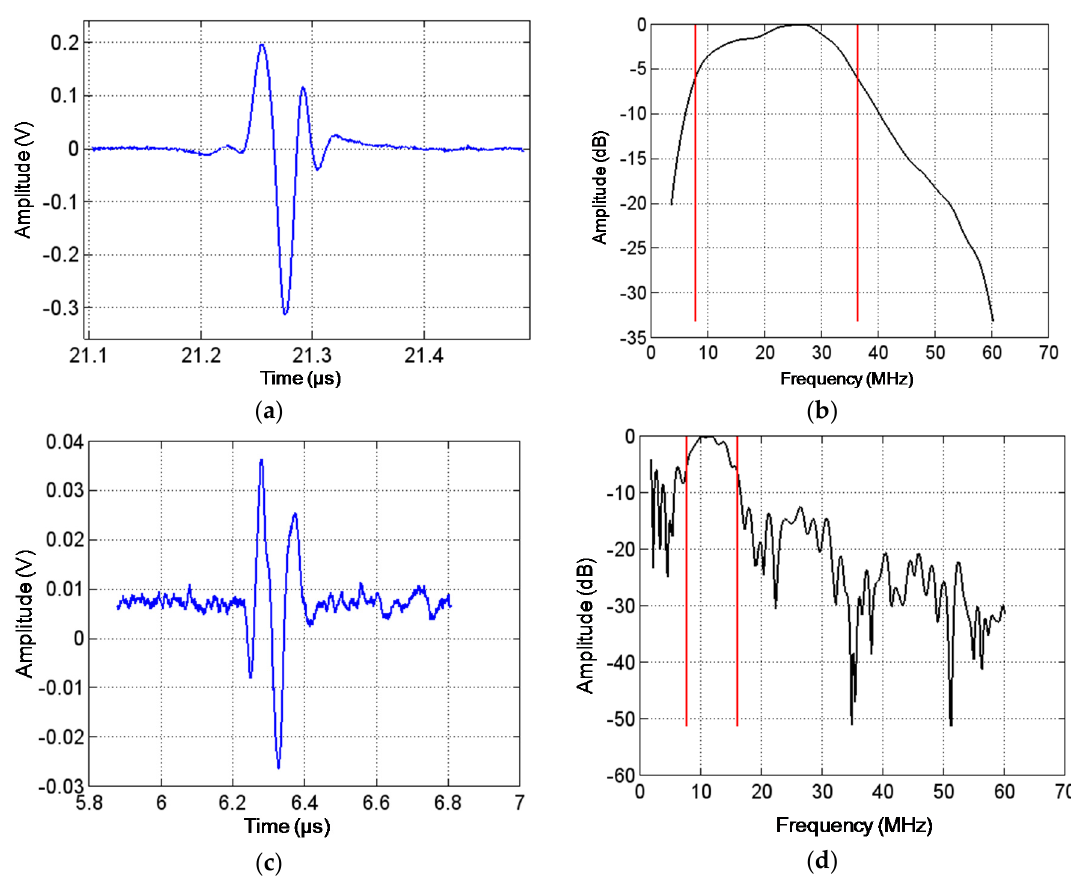
Figure 4. ( a ) Pulse-echo response of single-element thick-film transducer after excitation with a pulse with nominal amplitude of − 300 V and duration of 5 ns; ( b ) Normalised Fourier transform of the signal shown in ( a ); ( c ) Pulse-echo response of one thick-film array element after excitation with a pulse with nominal amplitude of − 300 V and duration of 30 ns; ( d ) Normalised Fourier transform of the signal shown in ( c ).